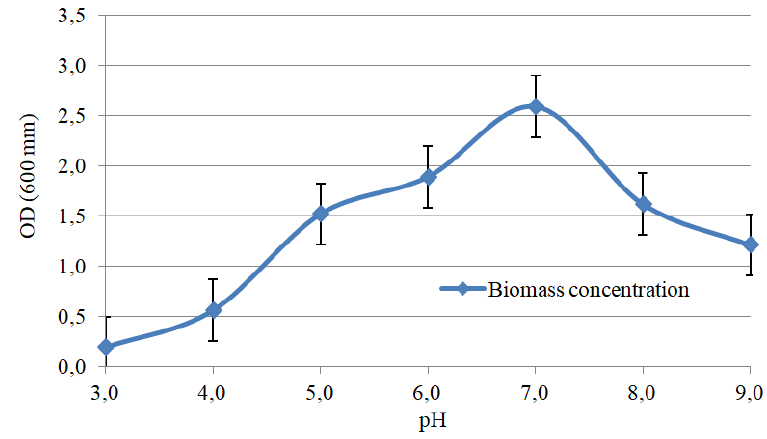
Figure 5. Effect of acidity on biomass accumulation: Consortium D.